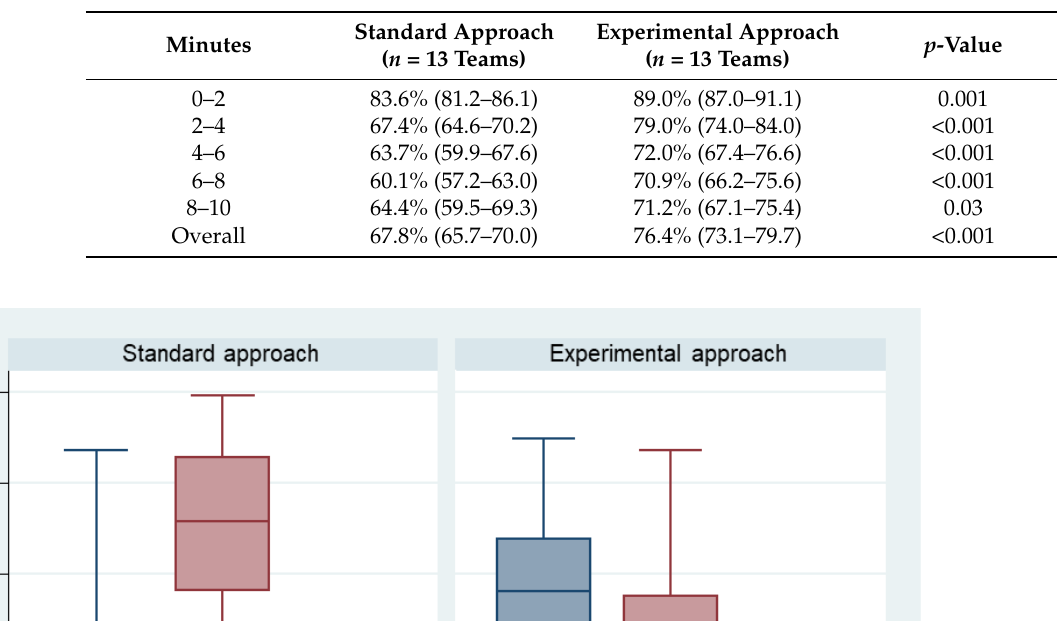
Table 2. Chest compression fraction, overall and per cycle expressed as mean (95% CI).